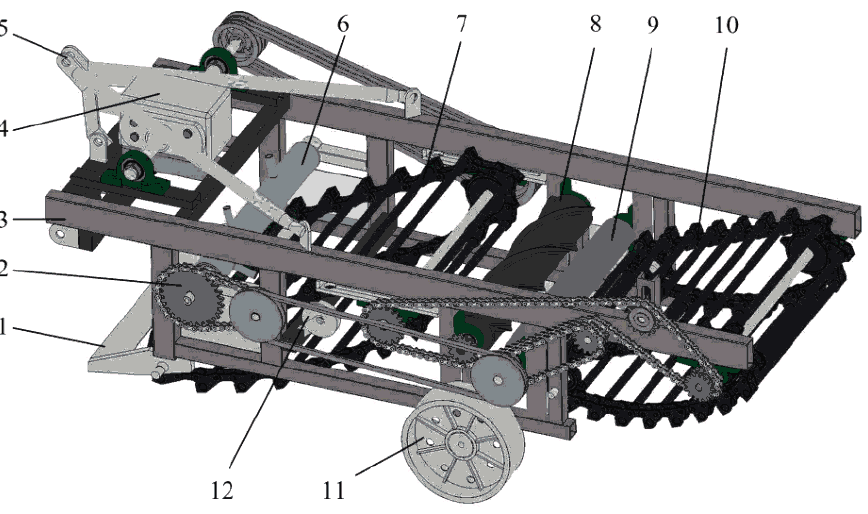
Figure 1. 3D model of potato harvester. 1—Digging shovel; 2—transmission system; 3—frame; 4—gear box; 5—traction frame; 6—soil-crushing mechanism; 7—first-stage lifting chain; 8—rubber roller; 9—smooth roller; 10—second-stage lifting chain; 11—walking wheel; 12—lifting chain sup- port wheel.